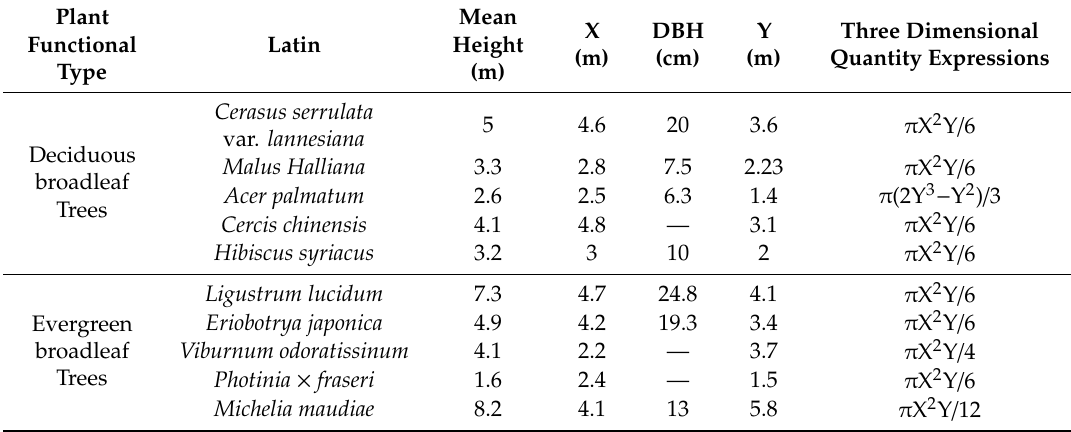
Table 1. Species characteristics of the ten species.